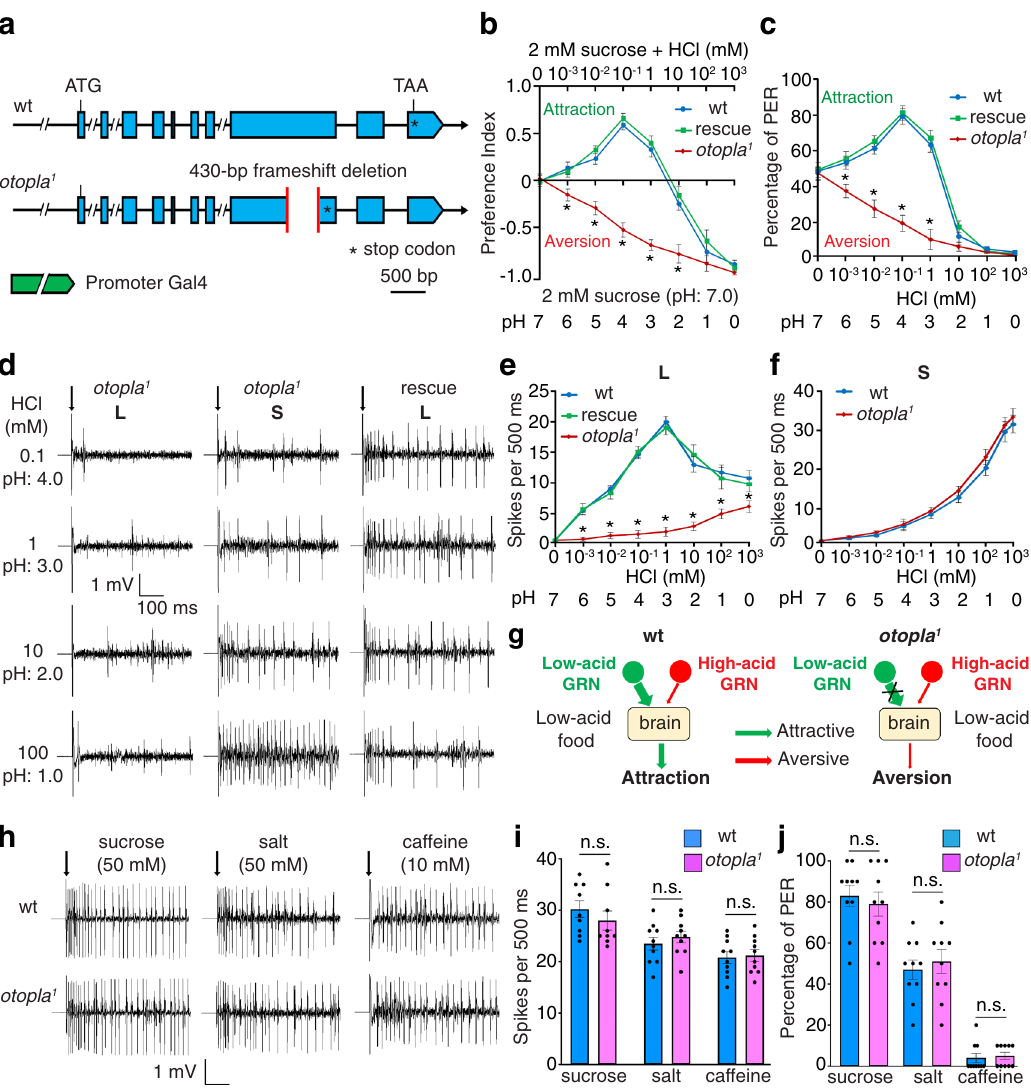
Fig. 2 Gustatory responses to acid and other tastants in wild-type (wt), otopla 1 mutant, and rescue ( otopla 1 ; otop-Gal4/UAS-otopla ) fl ies. a Genomic structures of wild-type and mutant otopla genes. * Represents stop codon. b Feeding responses to neutral foods vs. foods with varying HCl concentrations. Data are presented as mean ± SEM. n = 12 trials, * p = 0.007 (0.001 mM) and * p < 0.0001 (0.01, 0.1, 1, and 10 mM), one-way ANOVA tests. c PER responses to 30 mM sucrose with varying concentrations of HCl. Data are presented as mean ± SEM. n = 12 trials, * p = 0.0039 (0.001 mM) and * p < 0.0001 (0.01, 0.1, and 1 mM), one-way ANOVA tests. d Representative tip recording traces of L6 and S5 sensilla. Arrows indicate the onset of taste stimuli. e , f Dose – response curves showing spikes elicited by different concentrations of HCl in L6 sensilla ( e ; n = 10 animals, * p < 0.0001 (0.001 – 100